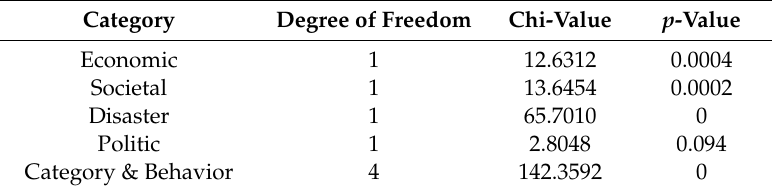
Table 5. Chi-square test of contingency results between user behavior and user location.